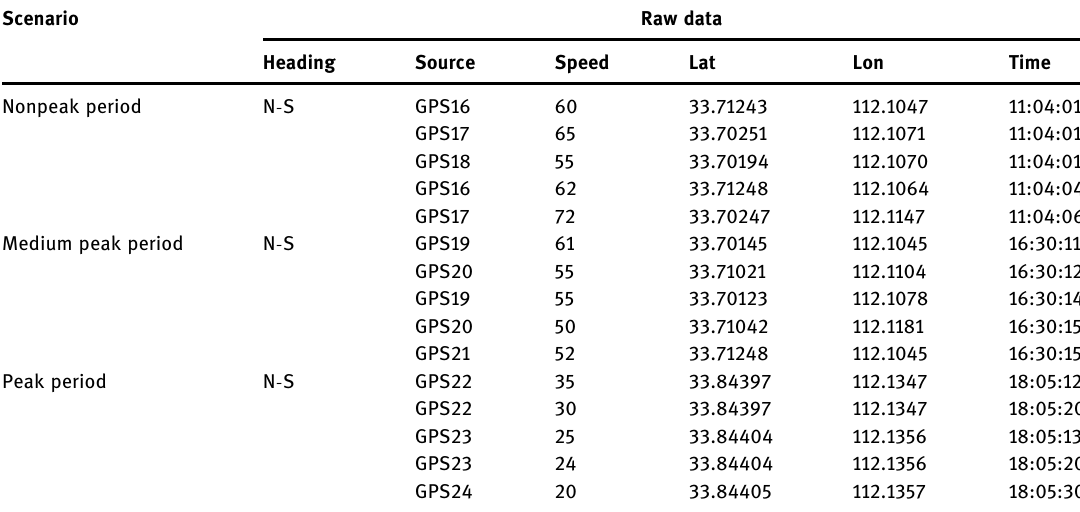
Table 2: Raw data samples of S904